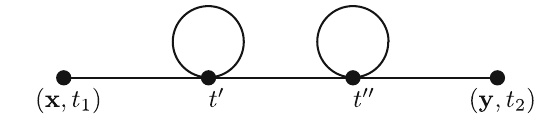
Fig. 2 Diagram with two independent loops